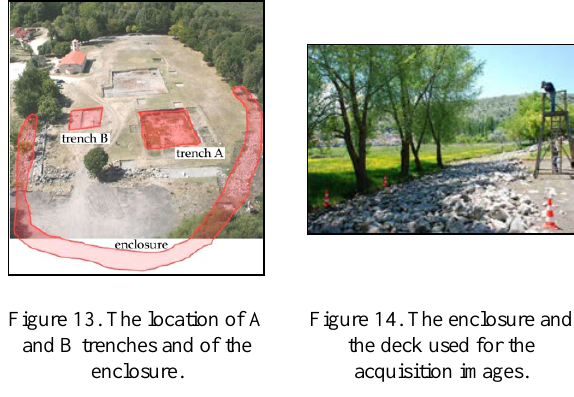
Figure 13. The location of A and B trenches and of the enclosure.